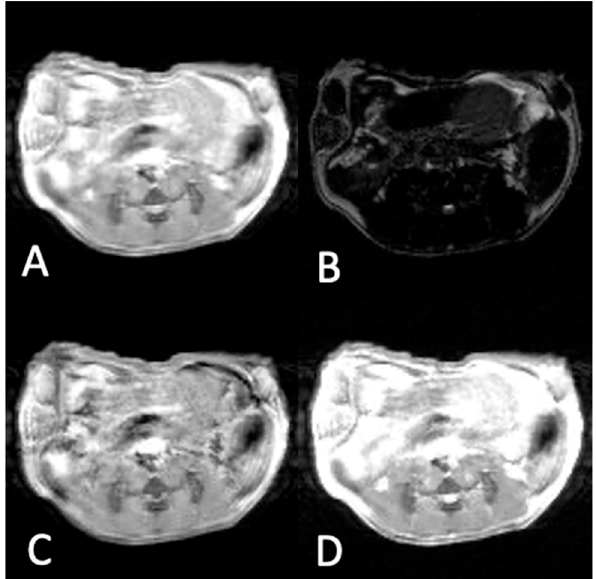
Figure 8. MR images of a mouse bearing TNB tumor 15 min post-injection of non-targeted NaDyF 4 /NaGdF 4 contrast agent: ( A ) T 1 w. ( B ) T 2 w. ( C ) Image obtained by the subtraction of ( B ) from ( A ). ( D ) image obtained by the addition of ( A , B ). The highest tumor contrast is obtained in image ( C ) and is equal to TC = 1.56.